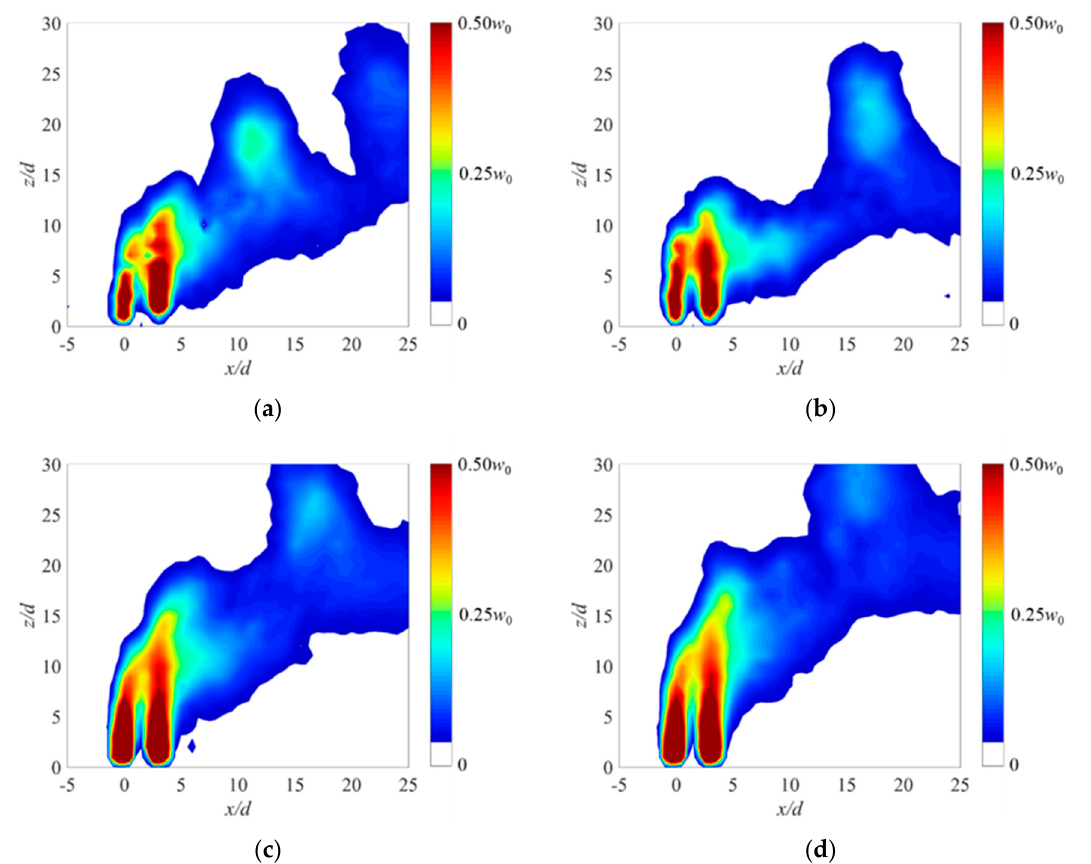
Figure 6. Phase-averaged vertical velocity distribution of the jet in the wavy cross-flow environment at the wave trough phase: ( a ) Case A2; ( b ) Case A4; ( c ) Case B3; ( d ) Case C3.